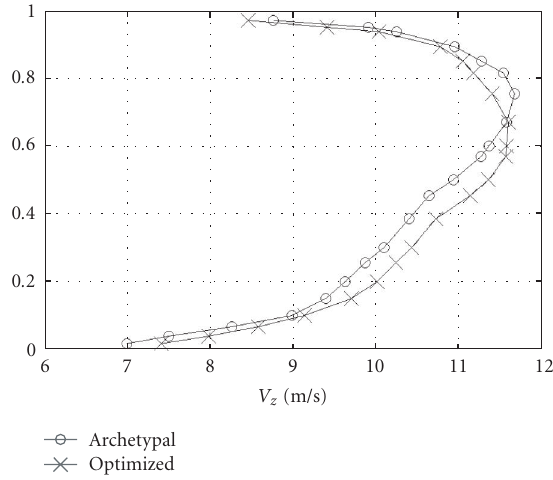
Figure 15: Spanwise distribution of axial